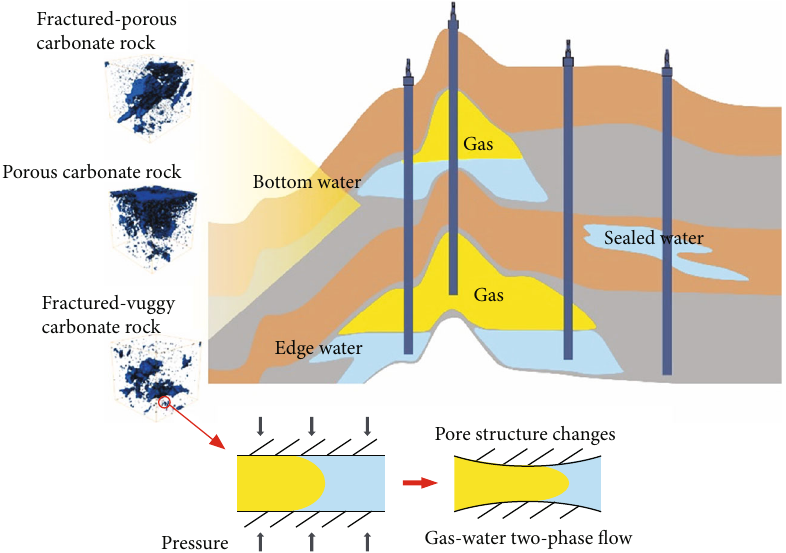
Figure 1: The change of percolation caused by the change of formation pressure and pore